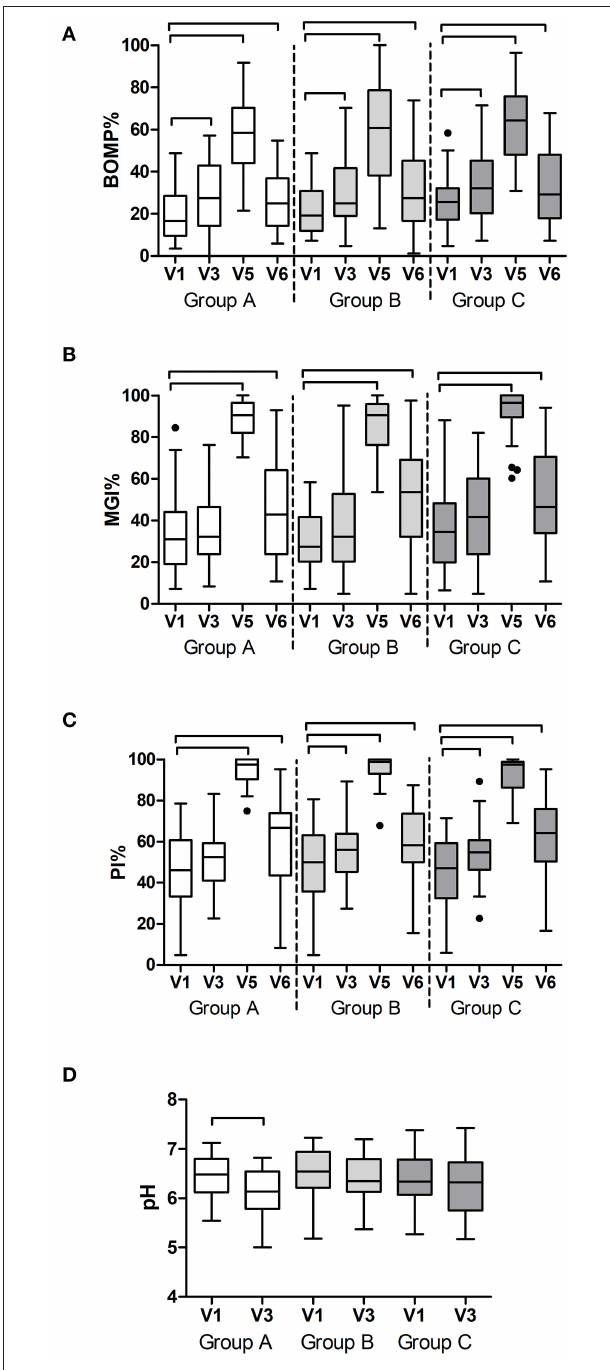
FIGURE 3 | Clinical findings per study group and visit: (A) prevalence of bleeding on marginal probing (BOMP%); (B) prevalence of gingival inflammation (MGI%); (C) prevalence of dental plaque (PI%) as a percentage of all sites at the baseline (V1), end of the wash-in period (V3), end of the experimental gingivitis period (V5) and end of the wash-out period (V6); and (D) pH of the dental plaque at the baseline visit (V1) and at the end of the wash-in period (V3). The connectors connect the visits that differed significantly ( P < 0.05, Wilcoxon Signed Ranks test) from the baseline visit.